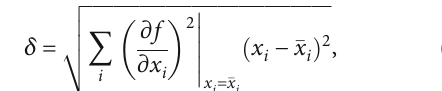
Figure 4: The numerical results of J curve is from the lower values; D and dotted curve is from the lower values.